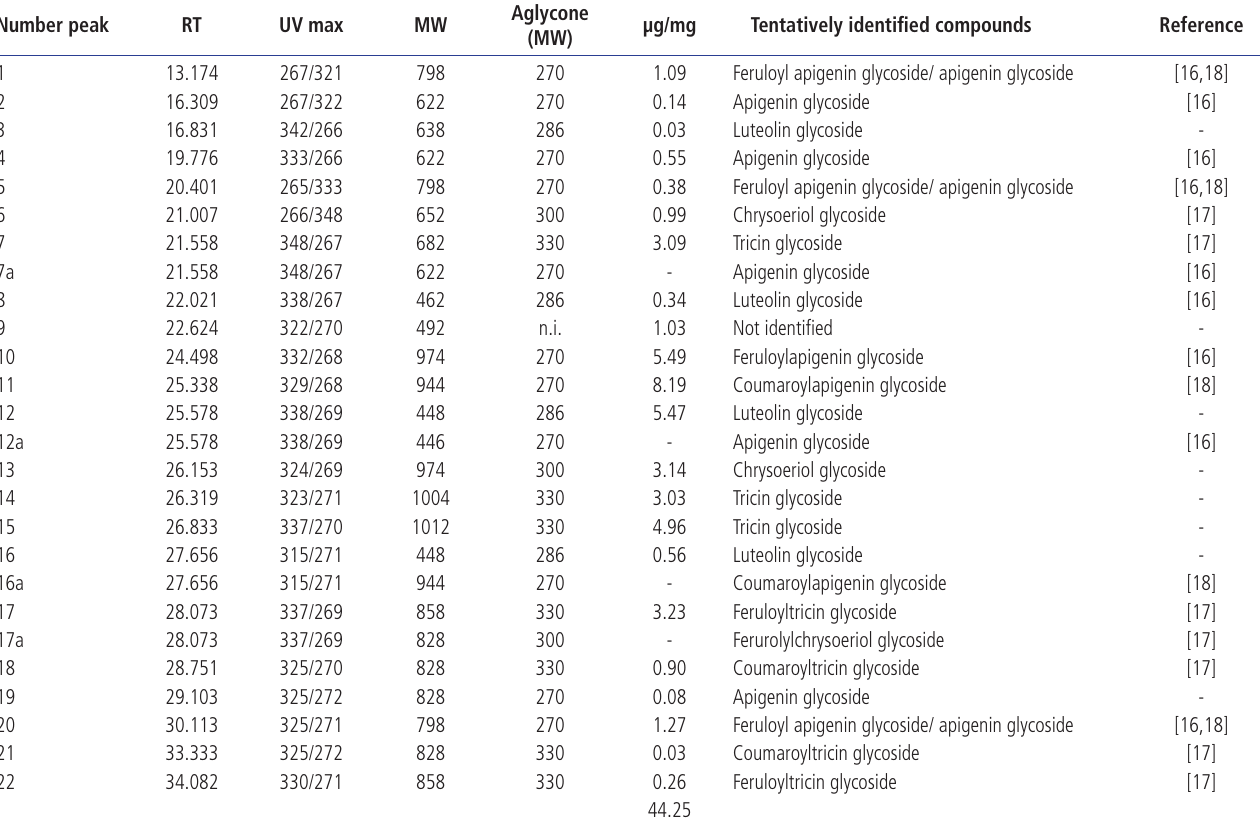
Table 1. Spectral data and relative content (μg/mg) of alfalfa flavonoids in water extracts analyzed by HPLC-PDA-MS/MS Number